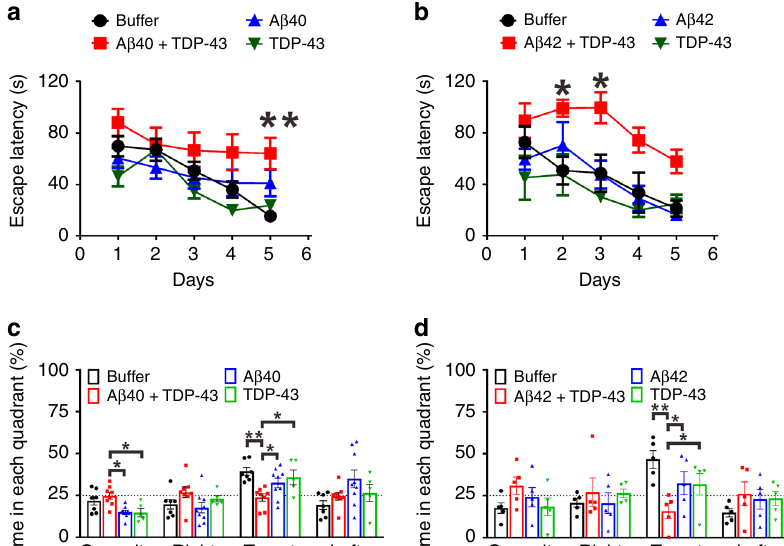
Fig. 5 TDP-43-induced A β species impairs hippocampus-related spatial memory to a greater degree than A β or TDP-43 alone does in the injected mouse model. WT mice at the age of 5-month were intracranially injected with the samples from the aggregation assays. A β , TDP-43, A β with TDP-43, and buffer obtained from the aggregation reaction were used. Spatial learning and memory functions were inspected by MWM 1 month after injection. Escape latency is de fi ned as the time at which the hidden platform is found. The data were colored for buffer control (black), A β and TDP-43 (red), A β (blue), and TDP-43 (green). a Training phase for A β 40. The sample sizes for buffer, A β 40 with TDP-43, A β 40, and TDP-43 are 7, 8, 9, and 5, respectively. The averaged data and s.e.m. are plotted. The statistical analysis was performed by repeated two-way ANOVA and Bonferroni ’ s post-hoc test, ** p < 0.01 (Buffer vs. A β 40 + TDP-43 at day 5, p = 0.0048). b Training phase for A β 42. The sample size for buffer, A β 42 with TDP-43, A β 42, and TDP-43 are 5, 4, 4, and 5, respectively. The averaged data and s.e.m. are plotted. The statistical analysis was performed by repeated two-way ANOVA and Bonferroni ’ s post-hoc test, * p < 0.05 (Buffer vs. A β 42 + TDP-43 at day 2, p = 0.0174; Buffer vs. A β 42 + TDP-43 at day 3, p = 0.0112). c Probe test for A β 40. The time in each quadrant were calculated in percentage. The averaged data and s.e.m. are plotted. The statistical analysis was performed by one-way ANOVA, Holm-Sidak ’ s multiple comparisons, * p < 0.05, ** p < 0.01 (In the opposite quadrant : A β 40 + TDP-43 vs. A β 40, p = 0.0147; A β 40 + TDP-43 vs. TDP-43, p = 0.038; In the target quadrant, Buffer vs. A β 40 + TDP-43, p = 0.002; A β 40 + TDP-43 vs. A β 40, p = 0.0425; A β 40 + TDP-43 vs. TDP-43, p = 0.0289). d Probe test for A β 42. The averaged data and s.e.m. are plotted. The statistical analysis was performed by one-way ANOVA, Holm-Sidak ’ s multiple comparisons, * p < 0.05, ** p < 0.01 (In the target quadrant: Buffer vs. A β 42 + TDP-43, p = 0.0019; A β 42 + TDP-43 vs. A β 42, p = 0.0311; A β 42 + TDP-43 vs. TDP-43, p = 0.0311). Source data are provided as a Source Data fi